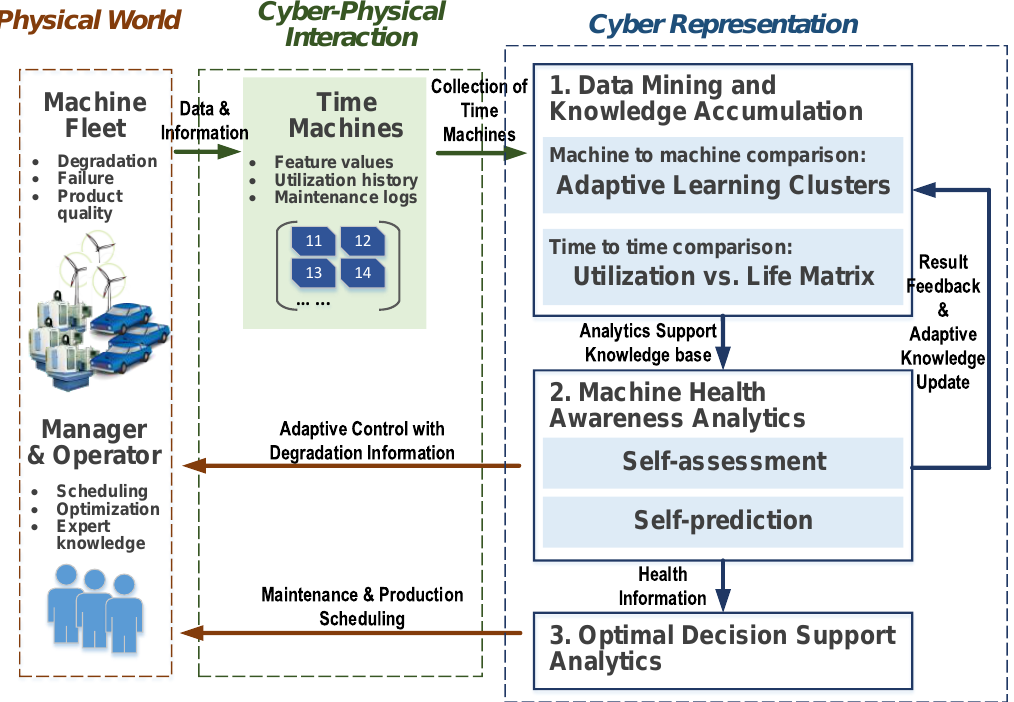
Figure 3. Cyber Physical Analytics Platform with Self Learning and Time Machine